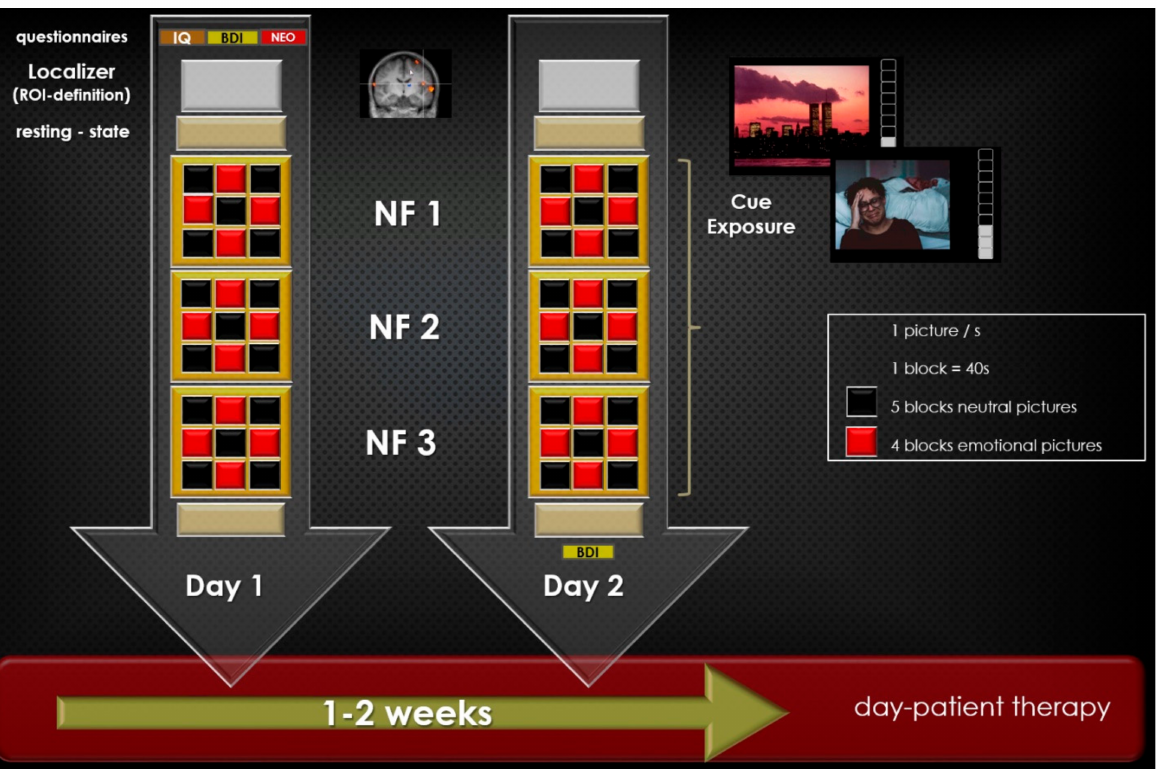
Figure 1. Experimental procedures: the subjects participated in two rtfMRI NF sessions within 2 weeks; in a functional localizer before each NF training, the ROIs insula and dlPFC were determined; during the functional localizer and NF training, neutral and negative emotion-related pictures were shown in blocks of 40 s with 40 pictures of the respective category. Participants were instructed to reduce brain activity during the presentation of the emotion-associated task. During the presentation of neutral information, participants were instructed to simply gaze at the pictures. Before and after each NF-training session, resting-state activity was acquired. NF trainings were embedded in a day-patient therapy. Abbreviations: NF: